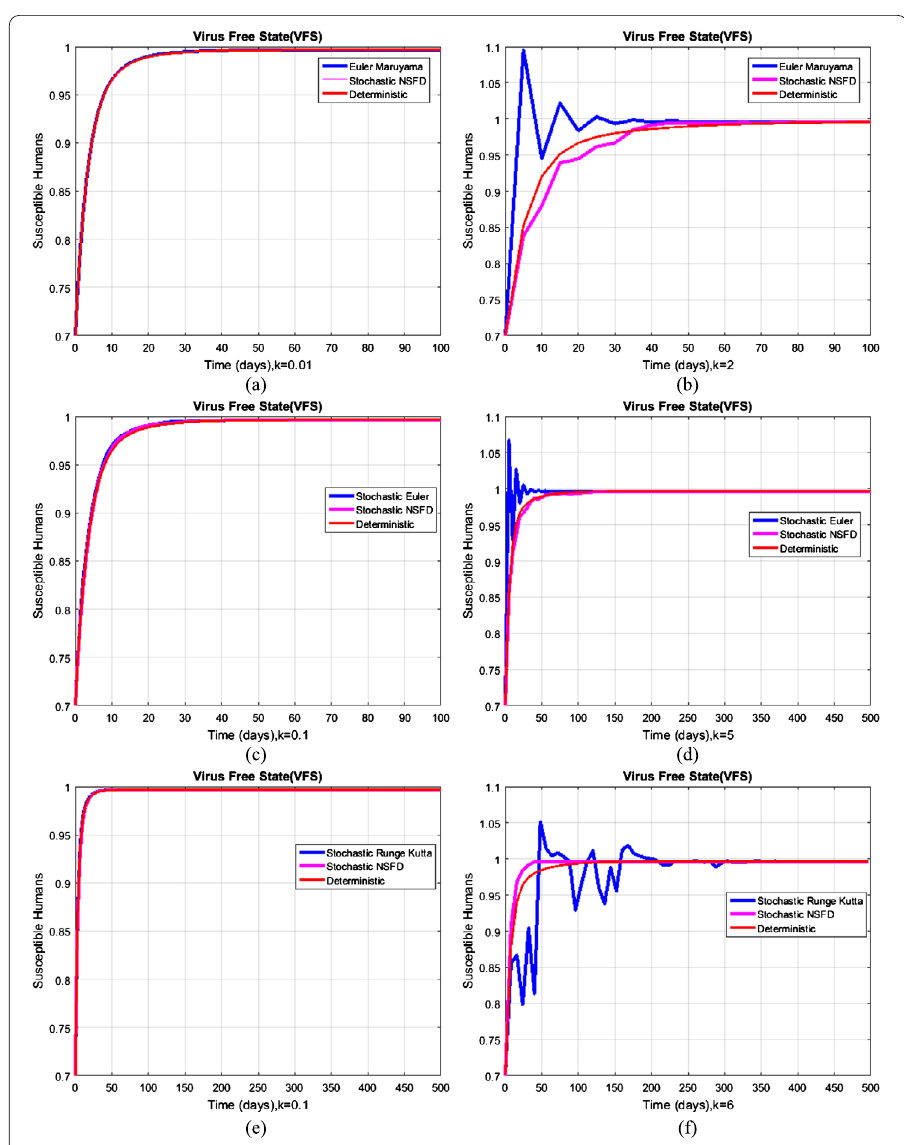
Figure 2 Comparison graphs of computational methods at the free of coronavirus state